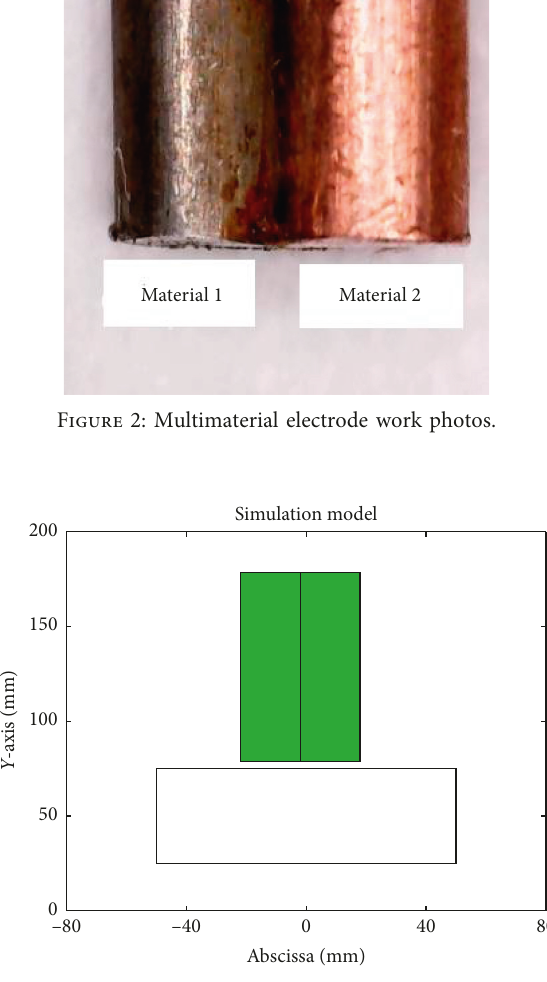
Figure 3: Two-dimensional model of multimaterial electrode workpiece